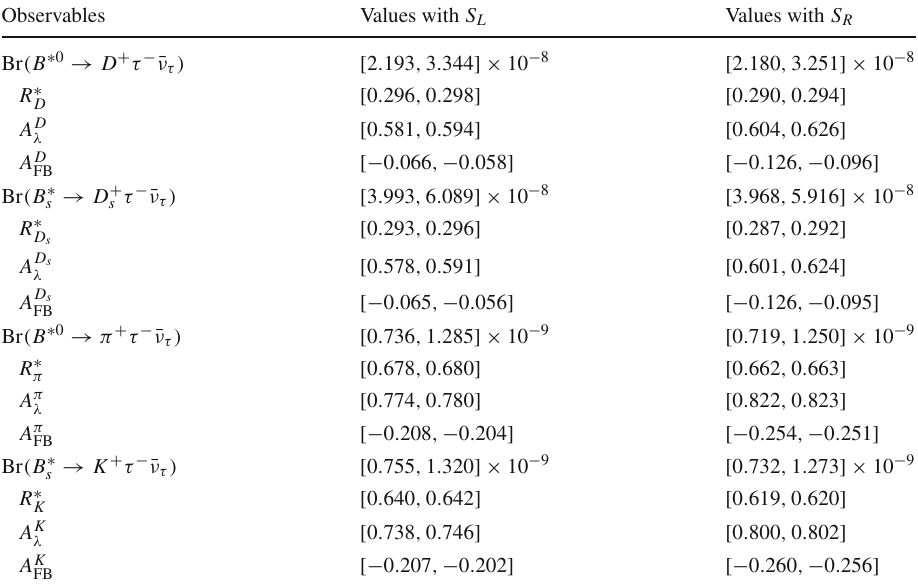
Fig. 5 The q 2 variation of lepton spin asymmetry and forward–backward asymmetry of ¯ B ∗ panel) in presence of S L coefficient only. The black dashed lines and the red bands are obtained by using the best-fit values and corresponding 1 σ range of S L coefficient